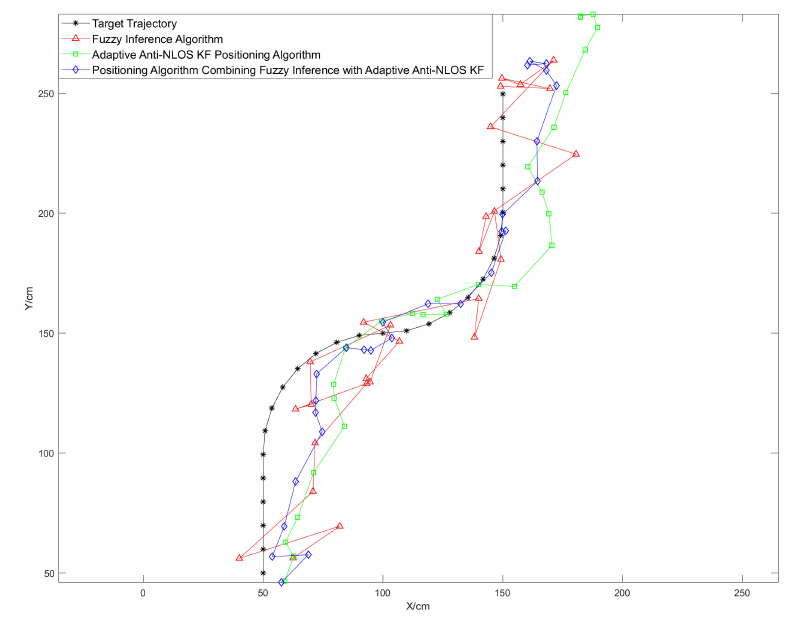
Figure 10. Positioning trajectories of the three